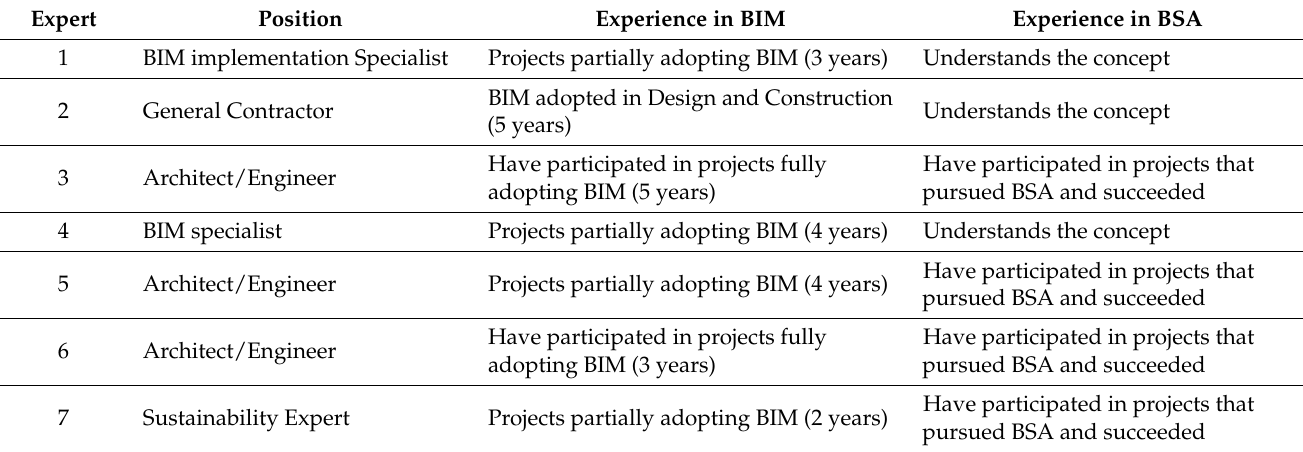
Table 5. General Background of the Delphi